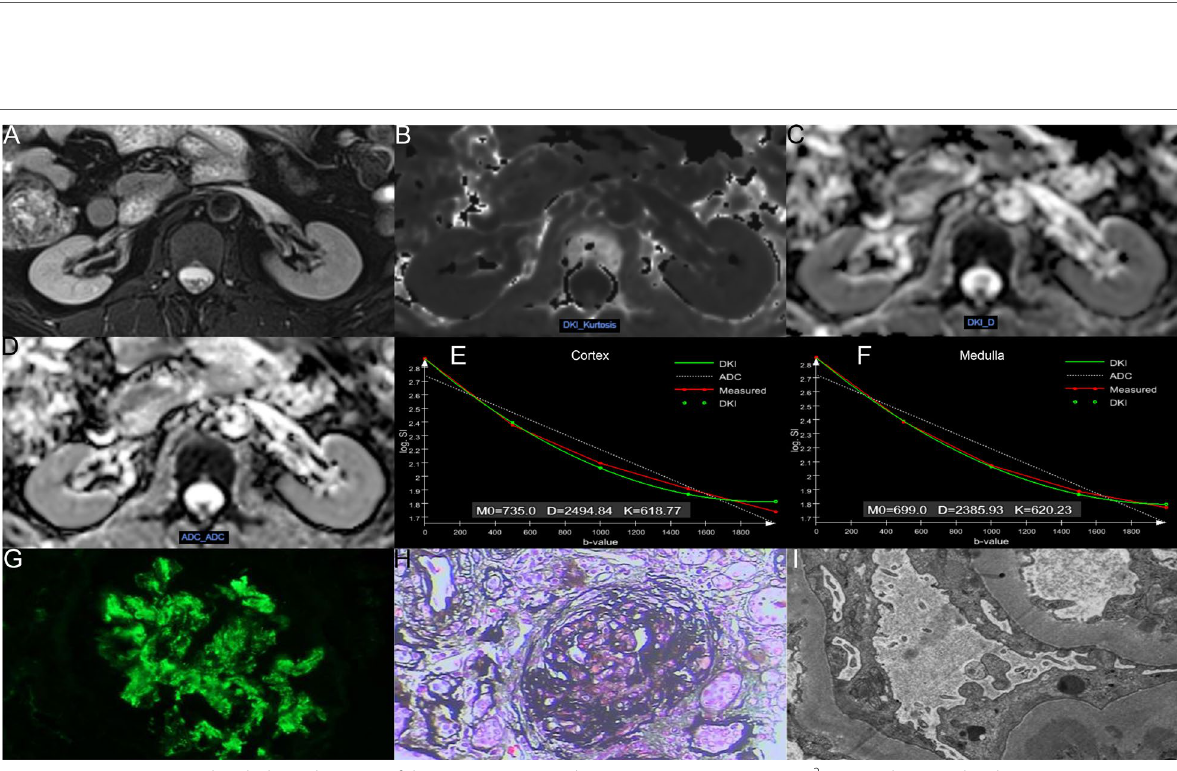
Fig. 4 Respective MRI and pathological images of the IgAN patients with eGFR cortex DKI fit, medulla DKI fit, immunofluorescence, light microscopy, and electron microscopy, respectively. The pathological result of this patient is